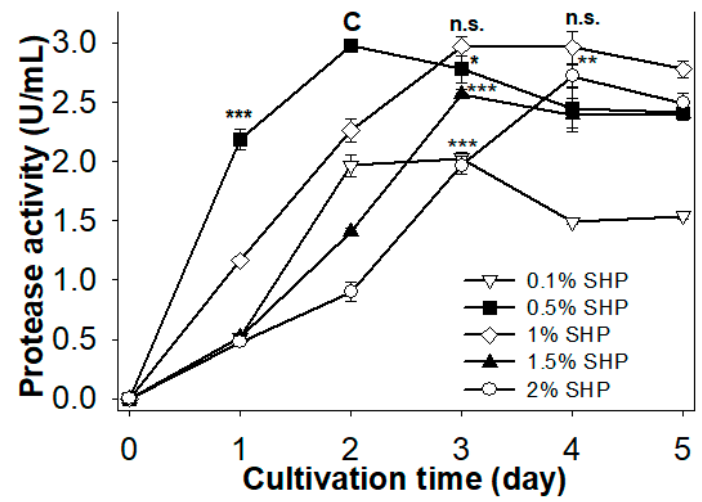
Figure 2. Effect of SHP concentration on protease production in Paenibacillus sp. TKU047. All points on the graph indicate the mean of each experiment (with n = 3) and standard deviation (error bar). The letters n.s., *, **, and *** indicate not significantly different or significantly different at p < 0.05, p < 0.01, or p < 0.001 (respectively) in comparison with the control group (C), based on one-way ANOVA analysis. Data point of 0.5% SHP on day 2 was used to signify the control group.